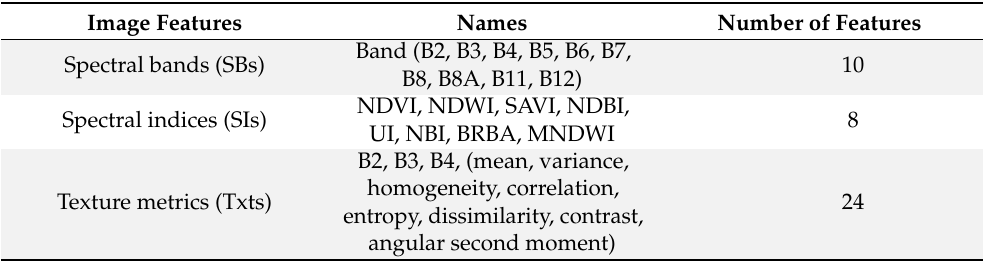
Table 1. Image feature sets that were extracted from Sentinel 2A